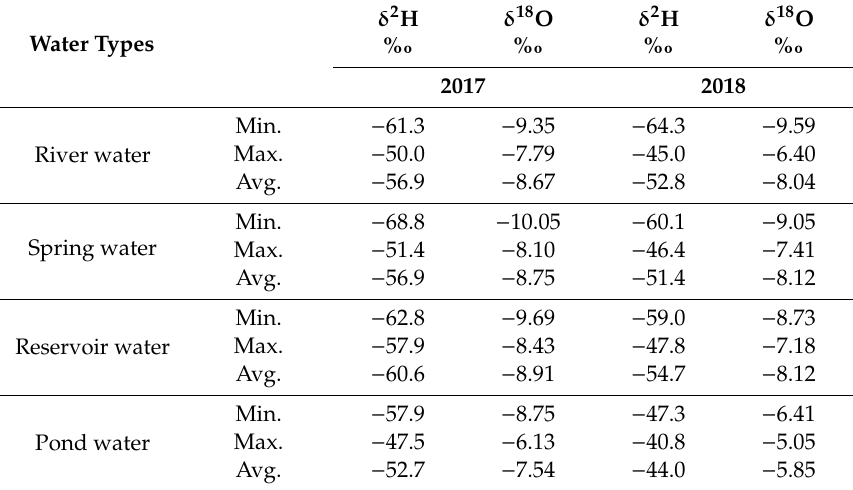
Table 3. Maximum, minimum, and average values of di ff erent types of water. Water Types